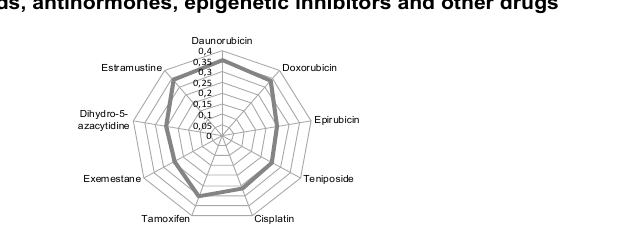
Figure 3. Oncobiograms of the cross-resistance profiles of the National Cancer Institute (NCI) cell line panel between secalonic acid and different classes of established anticancer drugs.